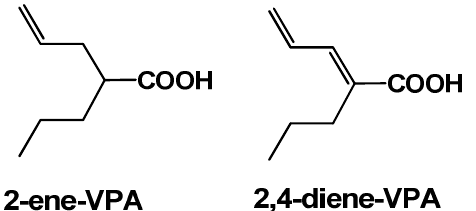
Figure 3. Structures of known hepatotoxic valproic acid metabolites: 2-ene-VPA and